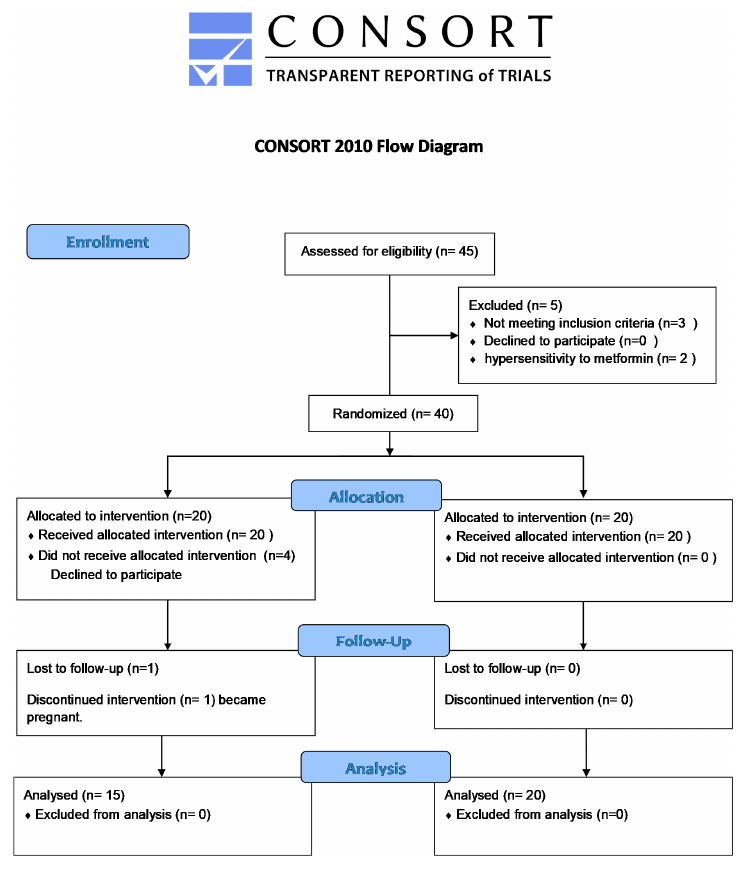
Figure 1. CONSORT 2010 flow diagram.